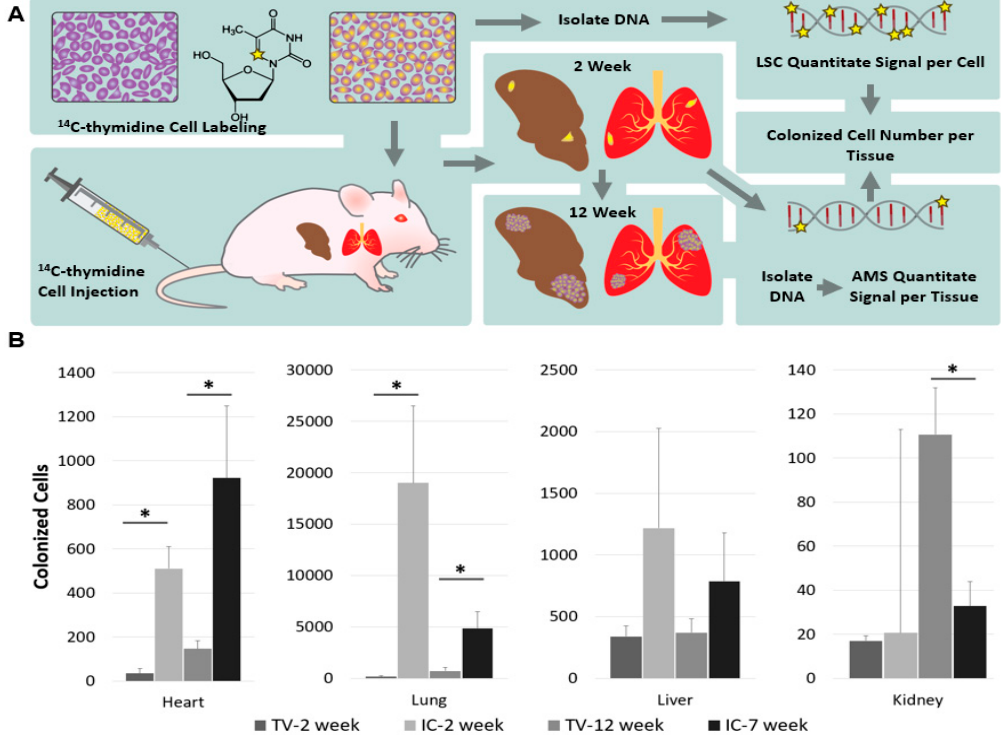
Figure 5. Workflow and validation of 14 C-labeling cancer colonization assay. ( A ) Schematic of colonization assay workflow. Cells were first cultured with 14 C-thymidine media to achieve single cell resolution and injected into NSG mice via the tail vein (TV), heart (IC), or subcutaneous (SQ) routes of delivery. Injected cells were allowed to metastasize for up to 12 weeks. Tissues were harvested at early (2 weeks post injection) and late (12 weeks post injection) time points and DNA was isolated and quantified using AMS. In parallel, the activity of 14 C-thymidine label in cultured cells was quantified using liquid scintillation counting (LSC). AMS measurements and LSC readings were combined to calculate the number of colonized cells per each organ examined. ( B ) Tail vein and intracardiac injected cancer cell colonization. Profile of colonized cells in target tissues calculated from 14 C signal in DNA from target tissues isolated at 2-weeks post injection, 7-weeks for intracardiac (IC), or 12-weeks for tail vein (TV) ( n = 5).